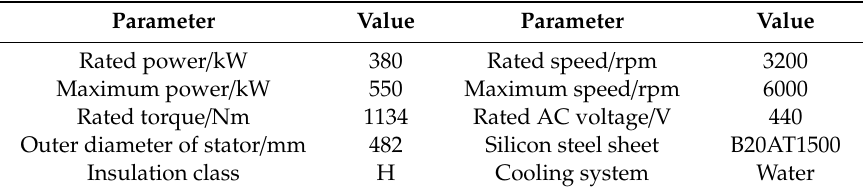
Table 1. The main parameters of the outer rotor